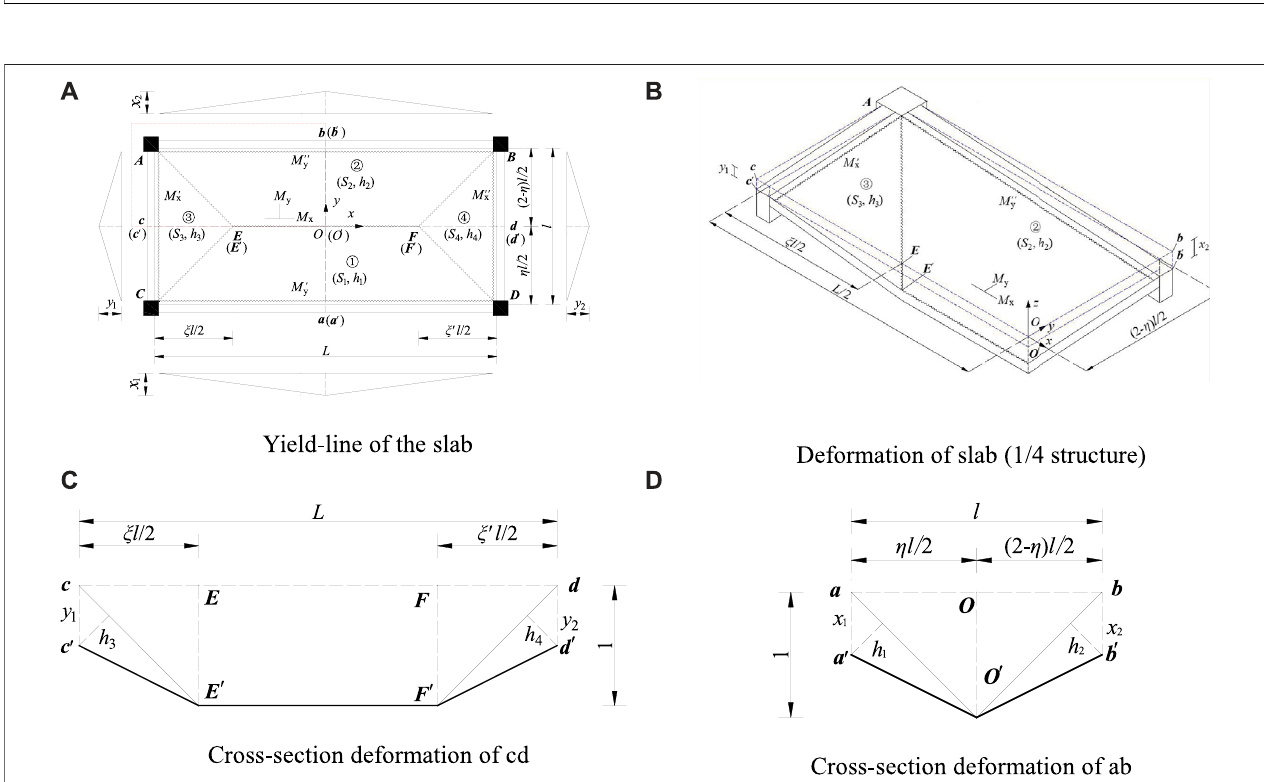
FIGURE4 | Failure modes ofthespecimens (A) Yield-line of theslab (B) Deformation ofslab (1/4structure) (C) Cross-section deformation ofcd (D) Cross-section deformation of ab.